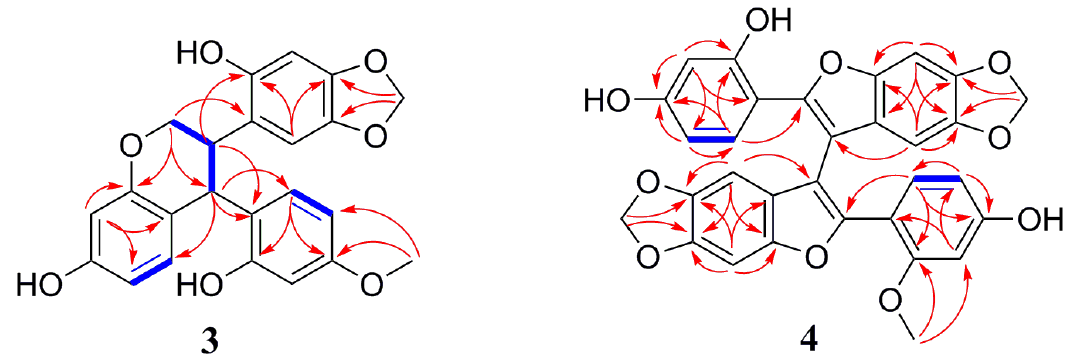
Figure 4. Key 1 H– 1 H COSY ( – ) and HMBC ( → ) correlations of 3 and 4 Figure 4. Key 1 H – 1 H COSY ( ─ ) and HMBC ( → ) correlations of 3 and 4 .